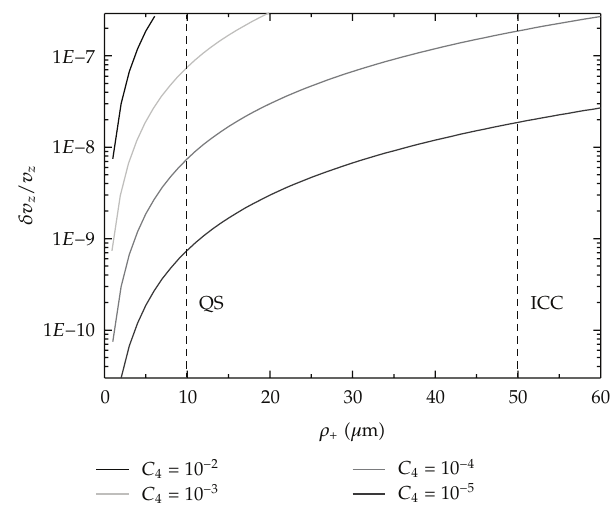
Figure 4: Relative variation of the axial frequency versus the modified-cyclotron radius of an ion with mass-to-charge ratio of 187. The y -axis is plotted up to δν z /ν z (cid:7) 2 . 9 × 10 − 7 , which is the limit to maintain the coupling between the ion of interest and the sensor ion (cid:5) 27 (cid:6) . Using (cid:3) 2.9 (cid:4) and (cid:3) 2.10 (cid:4) , the pairs 187 Re (cid:8) - 40 Ca (cid:8) and 187 Os (cid:8) - 40 Ca (cid:8) are coupled if their oscillation frequencies (cid:3) we consider ν within 29mHz (cid:5) 27 (cid:6) . The ions are moving in a 7T magnetic field, so that ν (cid:8) (cid:3) 187 Re (cid:8) (cid:4) (cid:7)